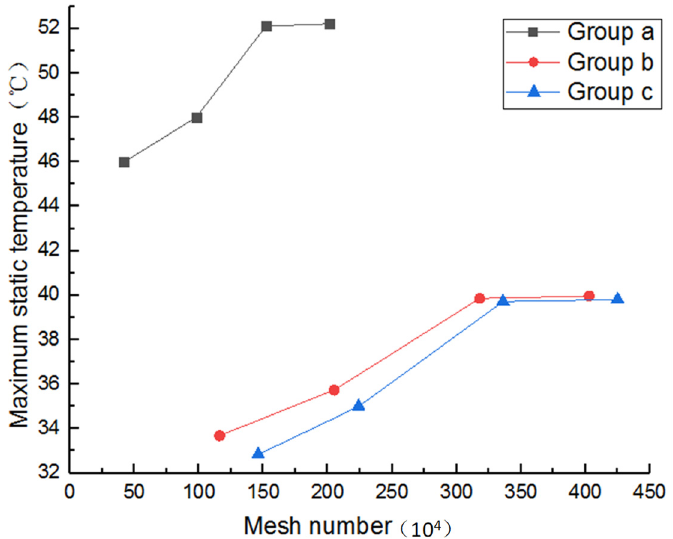
Figure 3. Mesh independence test.